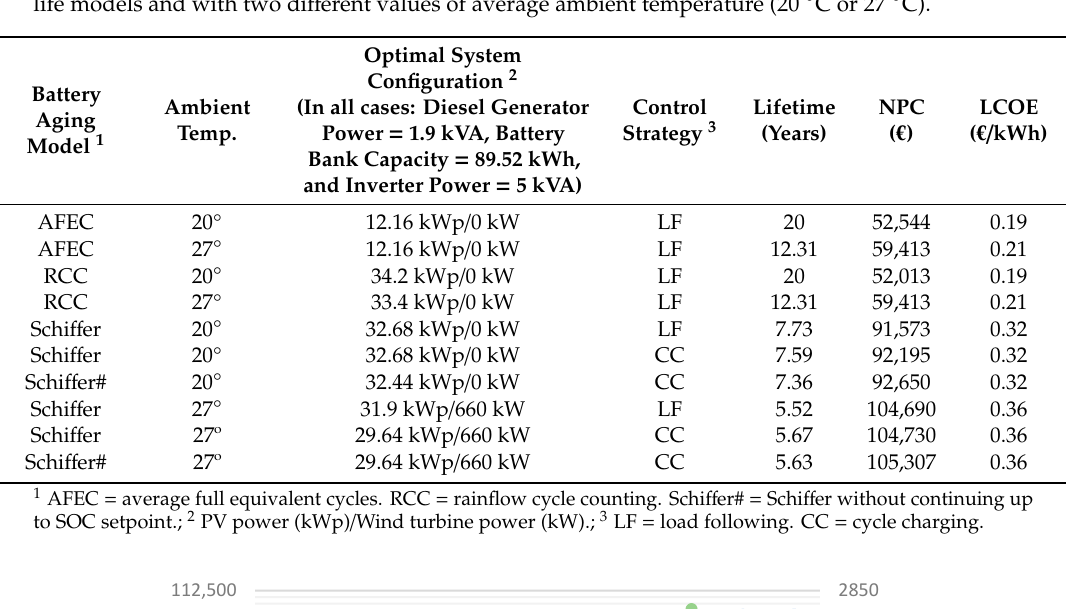
Table 11. Results of the system optimizations in the case of lead–acid batteries, using the three battery life models and with two different values of average ambient temperature (20 °C or 27 °C).